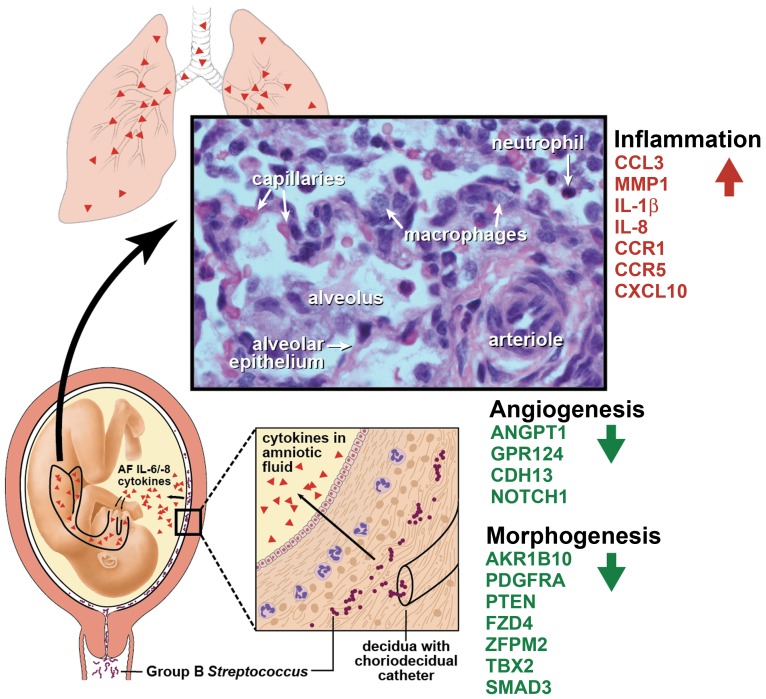
Our conceptual model of events leading to fetal lung injury in utero.First, bacteria from the vagina traffics into the choriodecidual space. Inflammation (e.g. IL-8) is produced by the decidua and/or membranes, which diffuses into the amniotic fluid and fetal lung. Fetal lung injury is induced by inflammatory mediators with significant genes shown involved in inflammation, cellular growth, and angiogenesis. IL, Interleukin; AF, amniotic fluid.